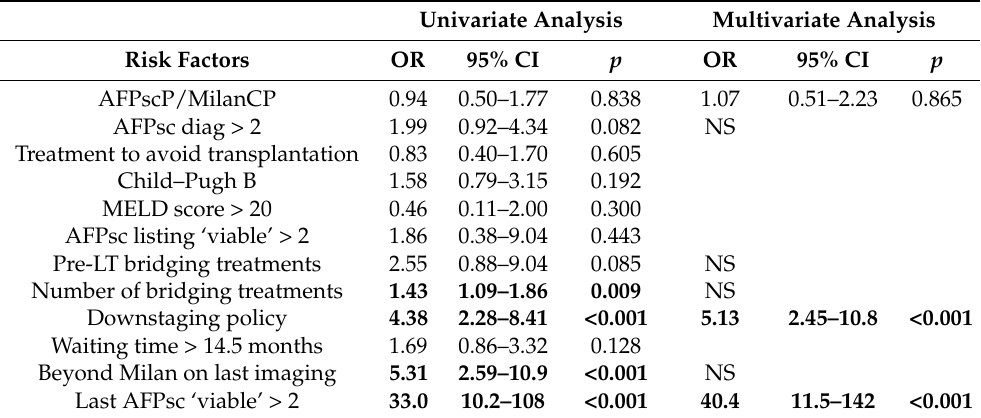
Table 3. Risk factors for noncompliance of the histological AFP score: univariate and multivariate analyses ( n = 364).